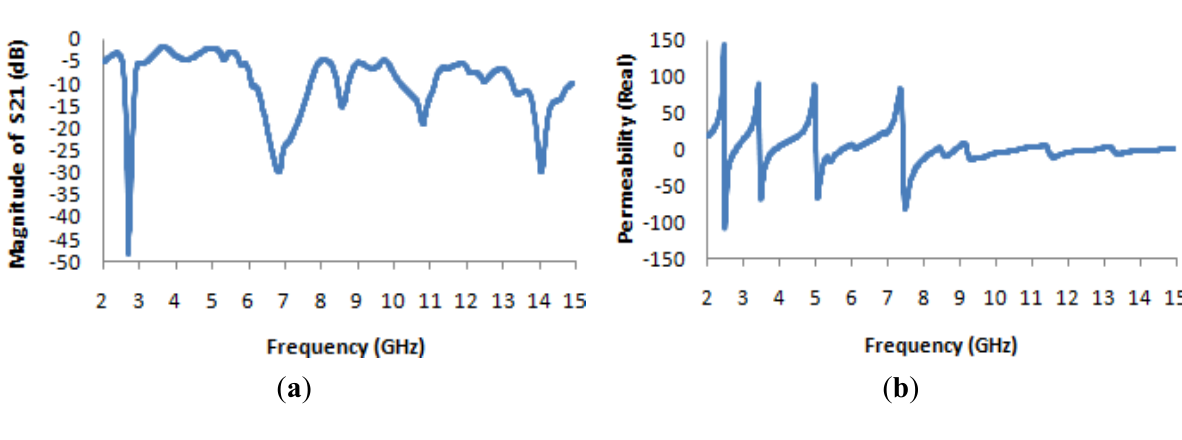
) in units of dB for the 21